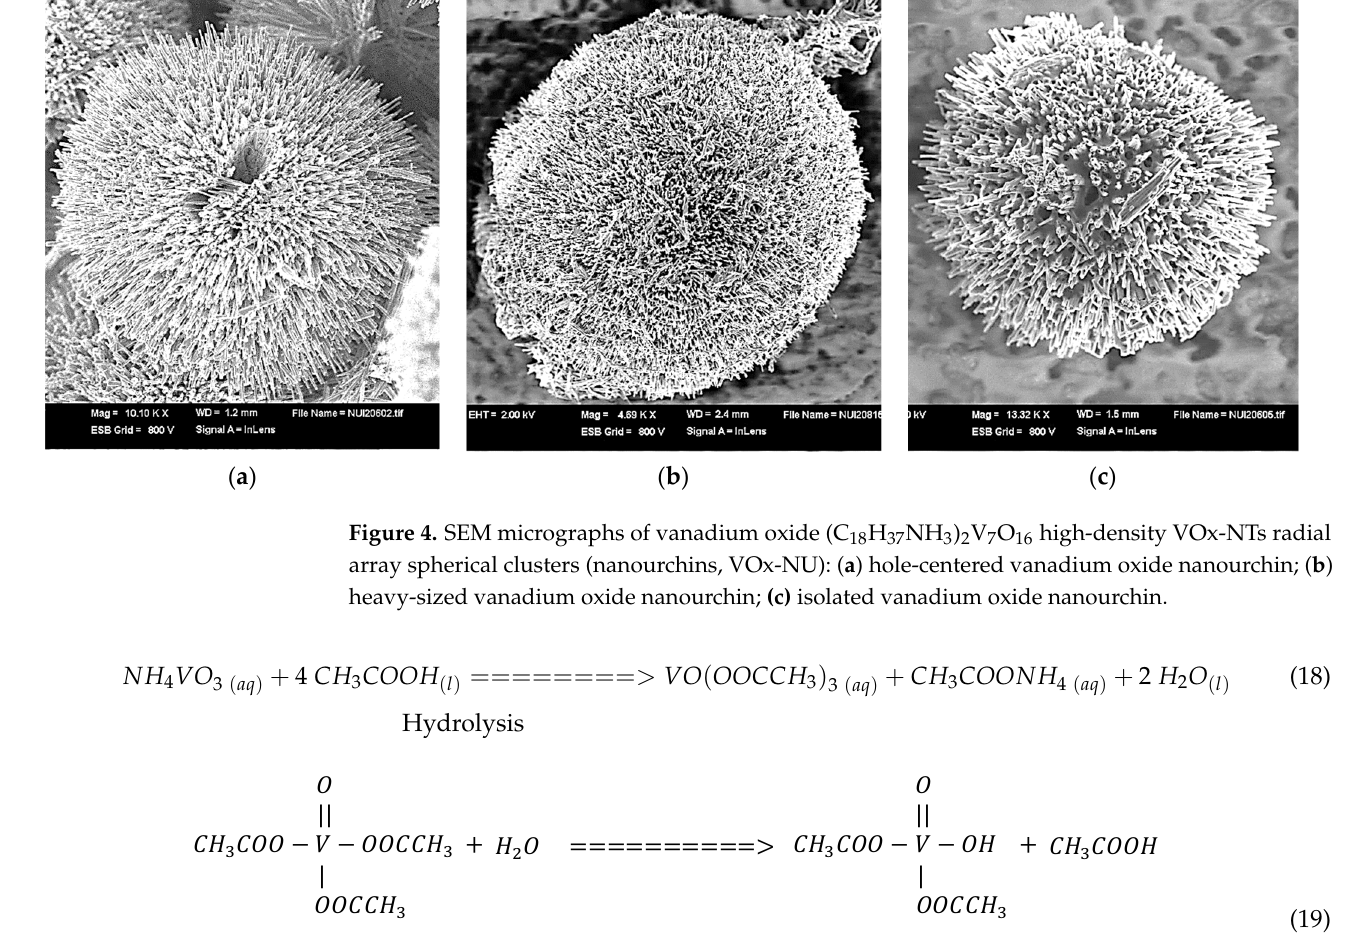
(cid:2871) ((cid:3028)(cid:3044))